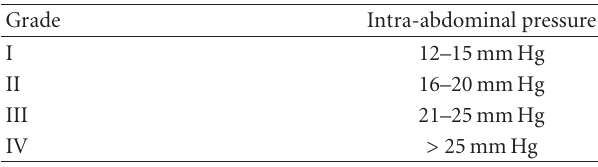
Table 3: Grades of intra-abdominal